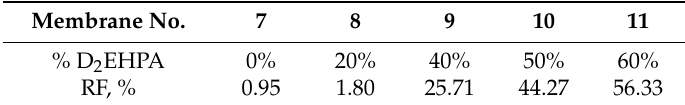
Table 3. Recovery factors (RF) for competitive transport of Zn(II) ions across PIMs with D 2 EHPA as a carrier. Membrane: PVC, 5% DAO, and D 2 EHPA. Feed phase: C Zn(II) = 5 mM, pH = 1.61; receiving phase: 0.1 M HNO 3. Membrane